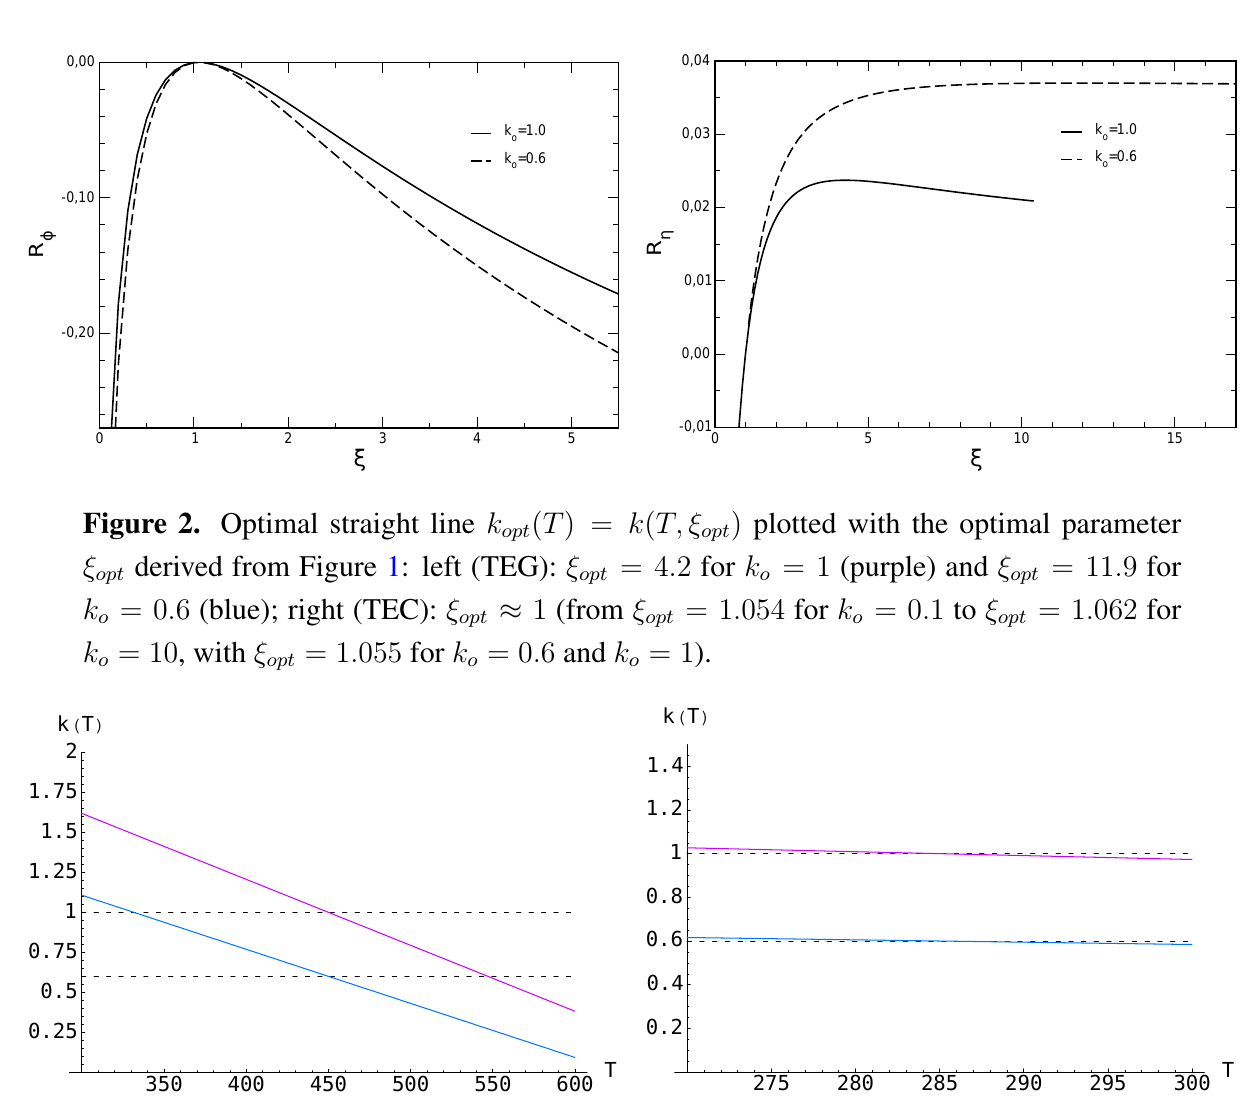
Figure 1. Relative performance increase R as function of the parameter ξ : left: R − 1 for TEG ( T = η /η ( k o ) = 600 K, T = 300 K ) for k = 1 (solid curve, optimal sc sc a s o = 4 . 2 ) and k = 0 . 6 (dashed curve, η = 11 . 9 , curve efficiency η at ξ at ξ sc,opt opt o sc,opt opt − 1 for TEC > 0 . 5 ); right: R = φ /φ ( k o ) slowly decreasing for ξ > ξ as long as k sc opt o φ sc = 270 K, T = 300 K ) for k = 1 (solid) and k = 0 . 6 (dashed), optimal coefficient of ( T a s o o = 1 . 0002 φ ( k o ) = 1 . 055 for both curves. performance φ at ξ sc sc,opt opt